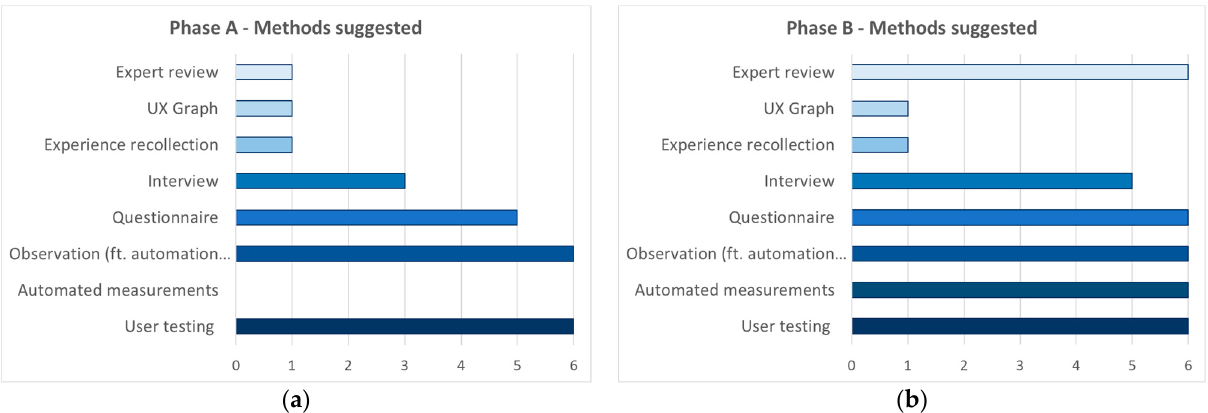
Figure 6. Methods suggested for the evaluation of UX in intelligent environments ( a ) without UXIE; ( b ) using UXIE.